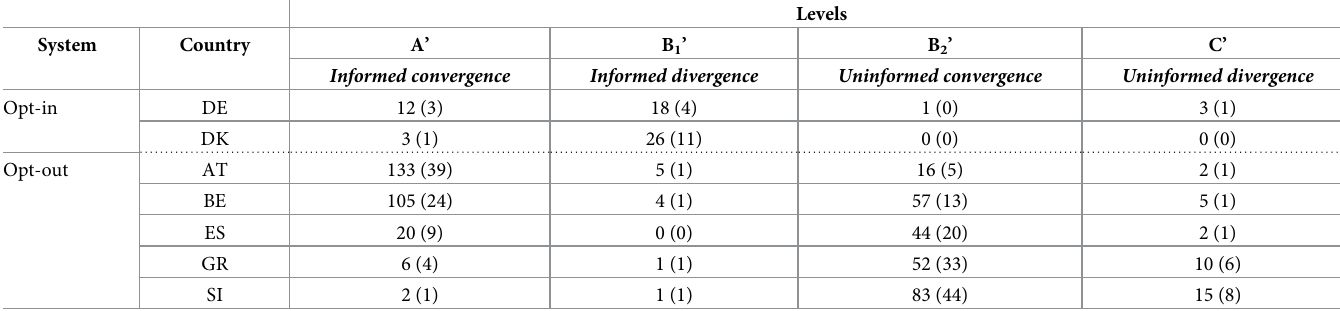
Table 7. Levels of governance quality: Respect for policy-dissenters unexpressed preferences (by country) and policy awareness.